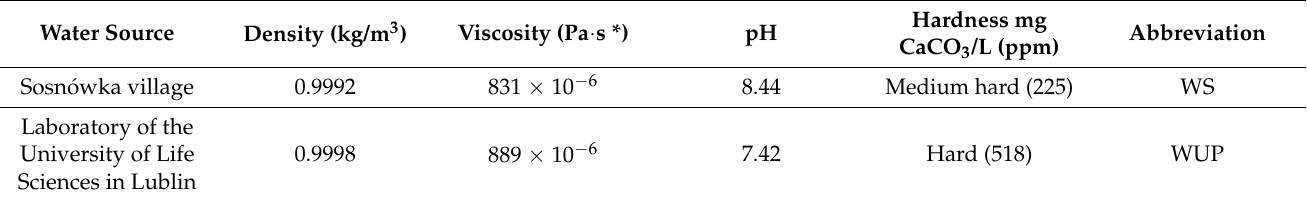
Table 3. The properties of water types used in the tests.